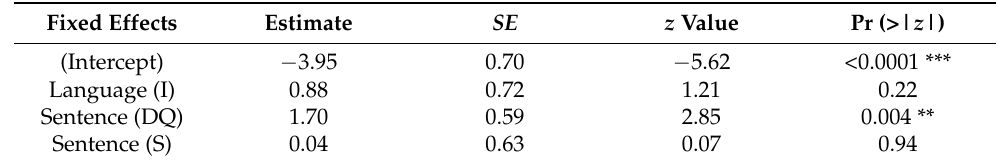
Table 8. Binomial mixed effects model with Language and Sentence Type as fixed effects (** p < 0.01;